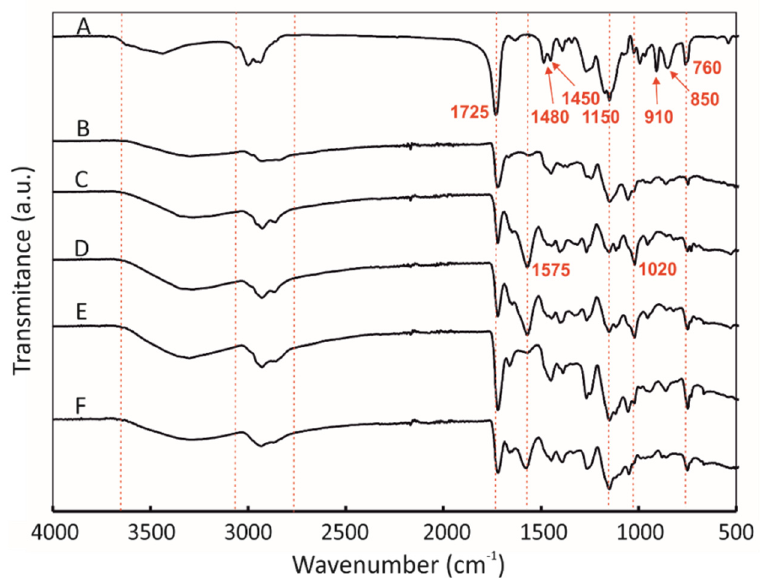
Figure 1. FT-IR spectra of (A) [P(EMA)- co -(GMA)], (B) [P(EMA)- co -(GMA)]-ETA( 1 ), (C) [P(EMA)- co -(GMA)]-Orn( 1 ), (D) [P(EMA)- co -(GMA)]-Xyl, (E) [P(EMA)- co -(GMA)]-ETA( 2 ), and (F) [P(EMA)- co -(GMA)]-Orn( 2 ).